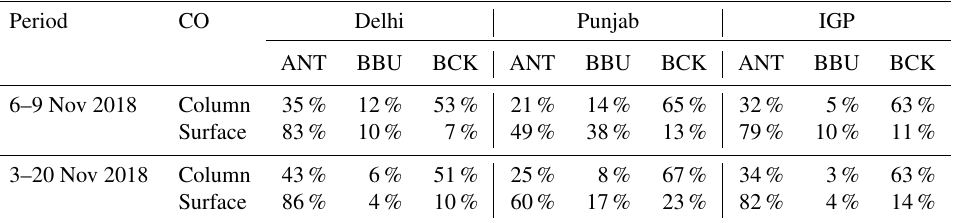
Table 5. Contributions from different emissions sources to the CO concentration between 6–9 and 3–20 November 2018. Abbreviations ANT, BBU, and BCK represent anthropogenic, biomass burning, and background signals, respectively (see Sect. 3). Period CO Delhi